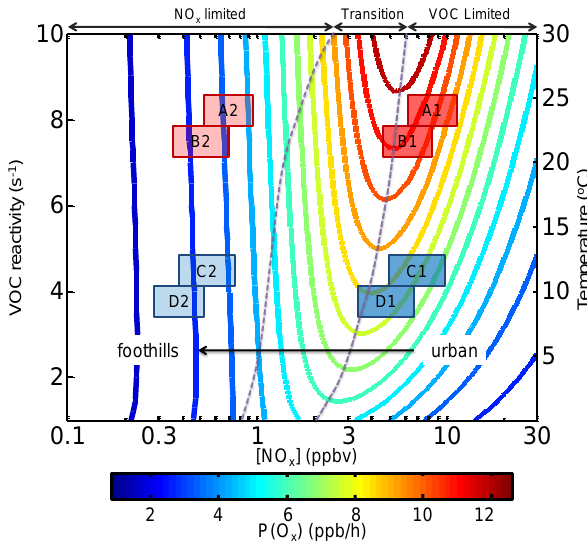
Fig. 4. Ozone production as a function of NO x , VOC reactivity, and temperature. Contour lines represent theoretical ozone production rates over a range of NO x and VOC reactivity phase space. See Sect. 5 for additional